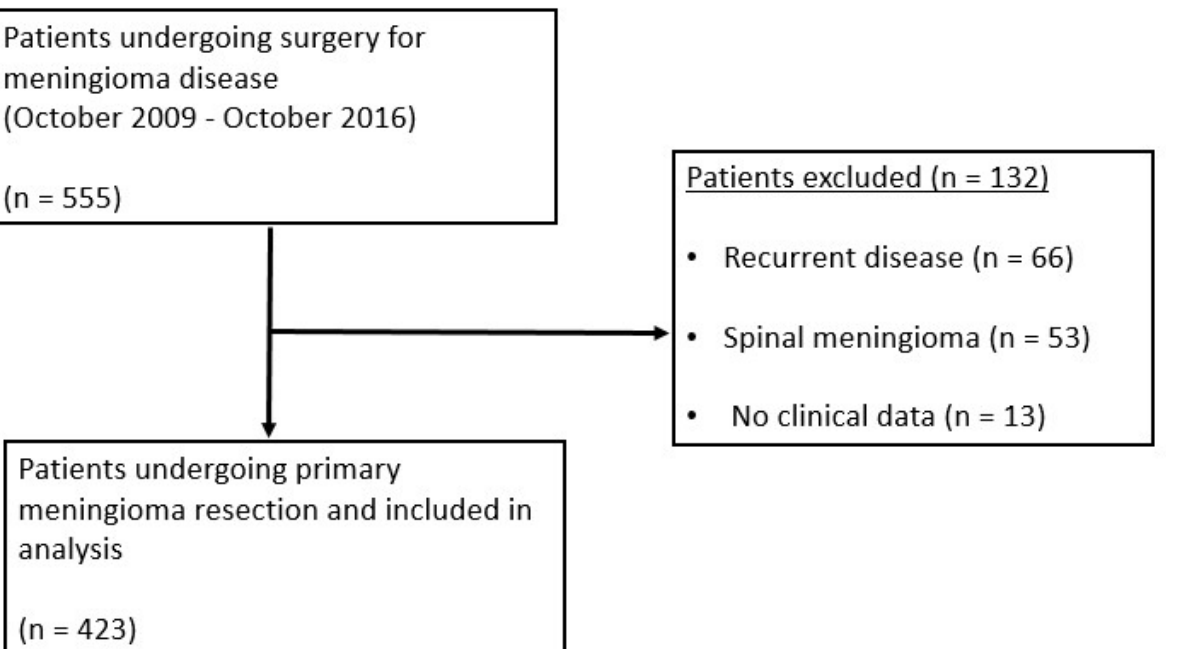
Figure 1. Flow chart of the selection process and overview of the study population